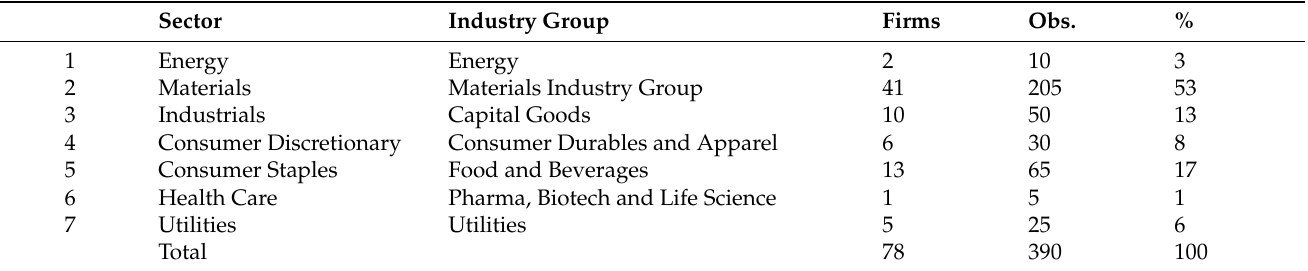
Table 1. Sample distribution by industry